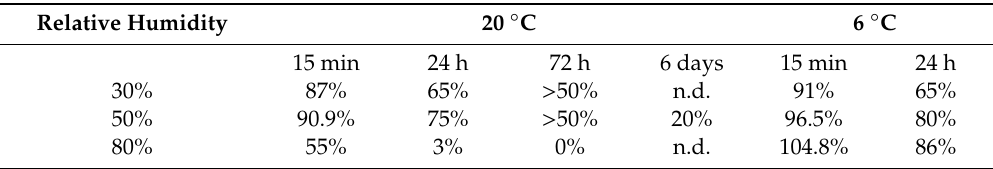
Table 2. Viability of the human coronavirus, HCoV 229E, as a function of time, temperature and humidity [93]. Relative Humidity 20 ◦ C 6 ◦ C 15 min 24 h 72 h 6 days 15 min 24 h 30% 87% 65% > 50% n.d. 91% 65% 50% 90.9% 75% > 50% 20% 96.5% 80% 80% 55% 3% 0% n.d. 104.8% 86% n.d. = not